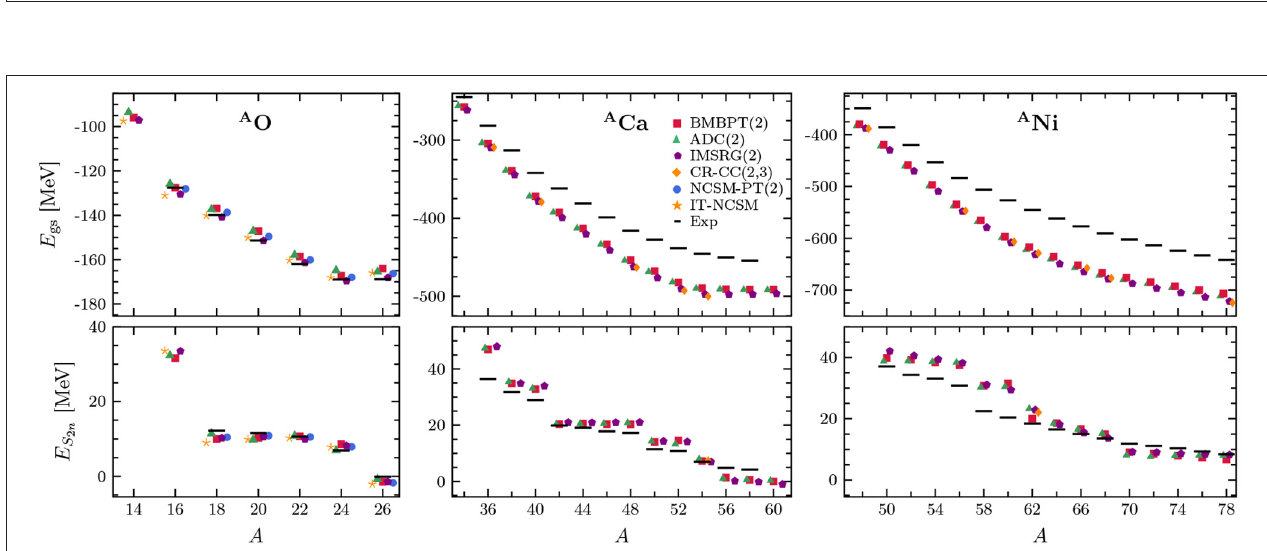
FIGURE 10 | Absolute ground-state binding energies (top) and two-neutron separation energies (bottom) along O, Ca, and Ni isotopic chains using the Hamiltonian defined in section 3. Plot markers correspond to second-order BMBPT ( (cid:4) ), second-order NCSM-PT ( l ), large-scale IT-NCSM ( ⋆ ), GSCGF-ADC(2) ( H ), MR-IMSRG(2) ( ), and CR-CC(2,3) ( (cid:4) ). All calculations are performed using 13 oscillator shells and an oscillator frequency of ¯ h ω = 20MeV. The SRG parameter is set to α = 0.08fm 4 . Reproduced from Tichai et al. [37] under the Creative Commons CC-BY license.